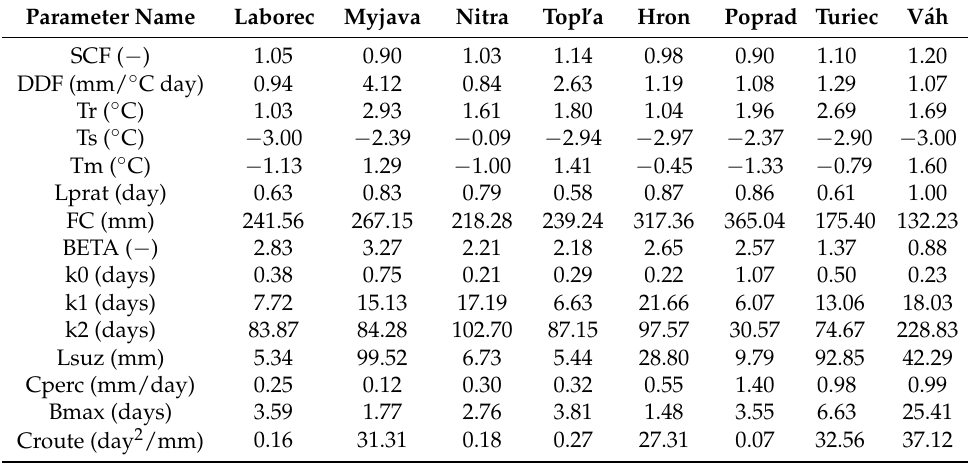
Table 5. The optimum HBV model parameters for eight studied